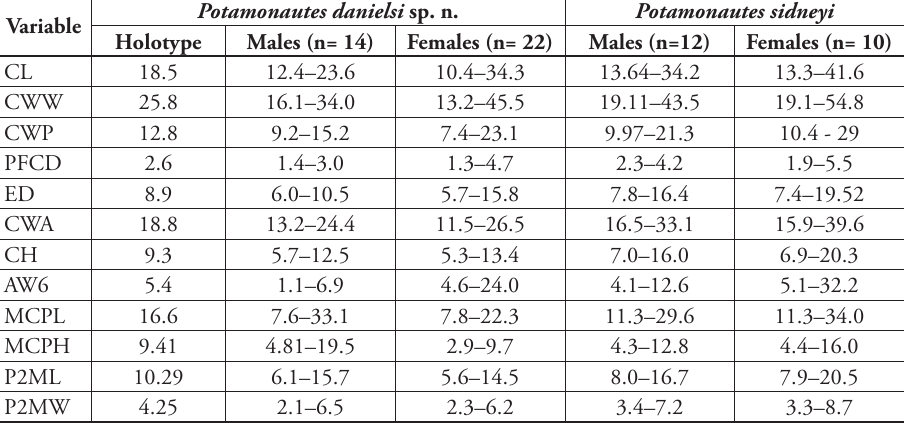
Table 1. Ranges of measurements (mm) for 12 morphometric variables of the P. danielsi sp. n. holotype and paratypes collected from Mtamvuna, Oribi Gorge and Mhlanga, as well as P. sidneyi (Rathbun, 1904) specimens collected from Lake Sibaya, Hluhluwe, Mpophomeni Stream and